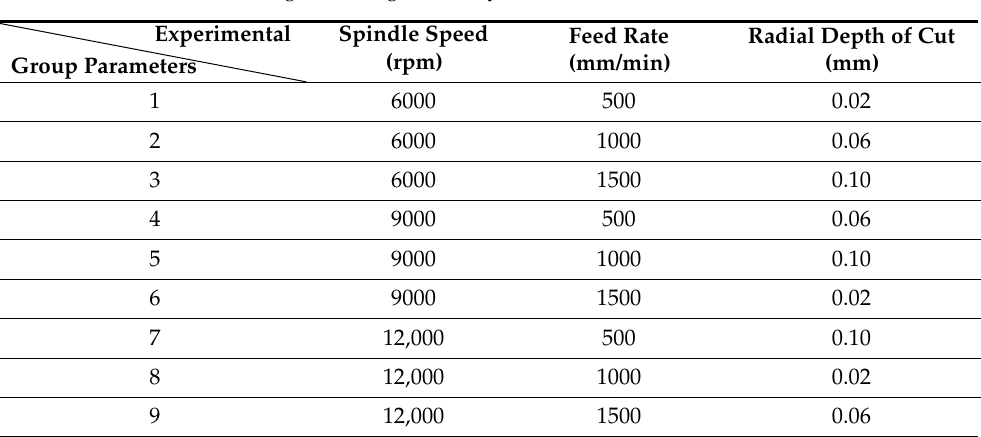
Table 3. Silicon nitride milling L9 orthogonal